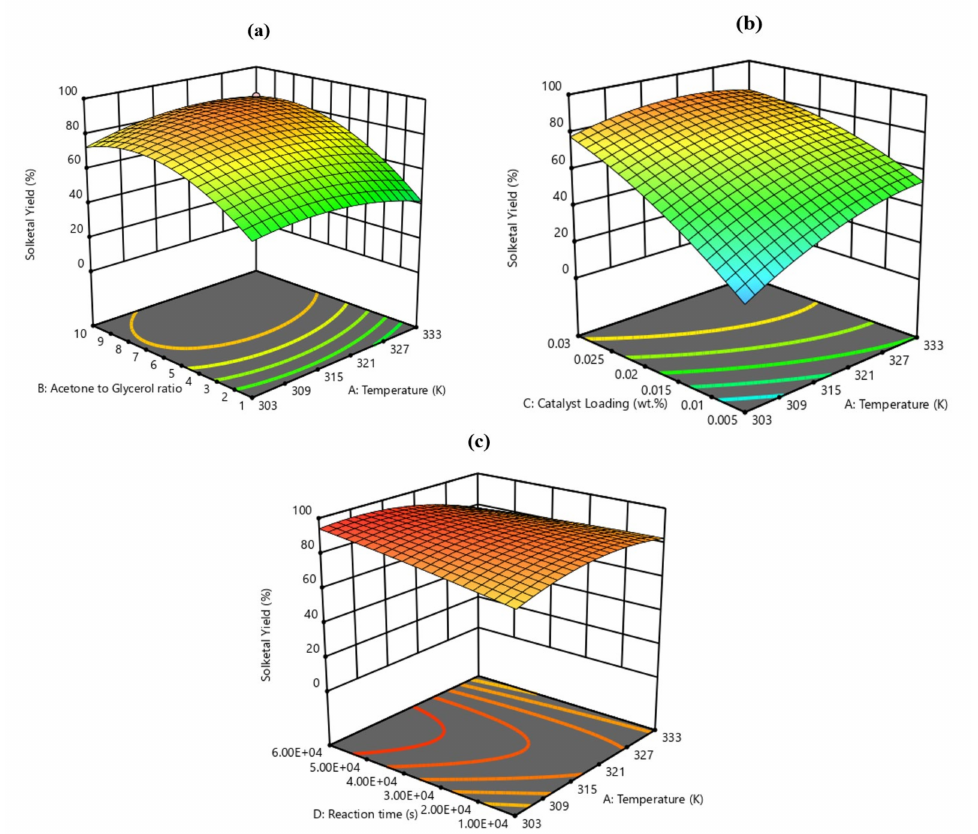
Figure 10. Surface plots for solketal synthesis for the interaction of reaction temperature with ( a ) acetone to glycerol molar ratio ( b ) catalyst loading ( c ) reaction